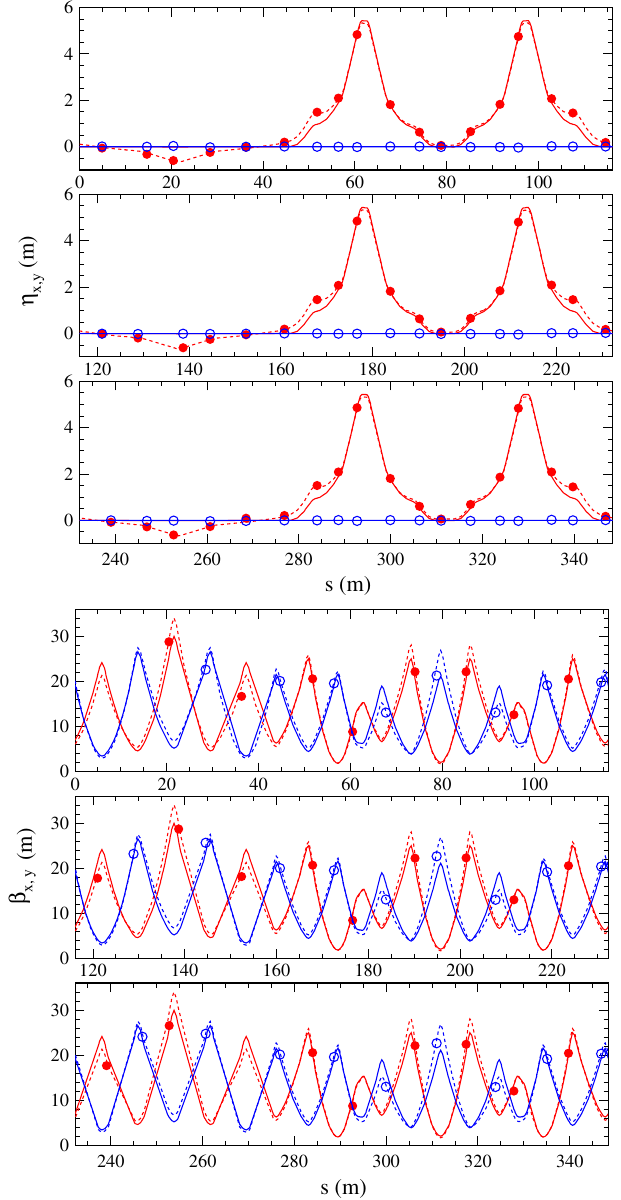
FIG. 6. (Color) Dispersion (upper) and betatron amplitude (lower) functions observed in each first measurement in the beam storage mode, where closed red circles are the horizontal ones, open blue circles the vertical ones, dashed curves show the reconstructed optical functions in our calculation model, and solid curves the design.